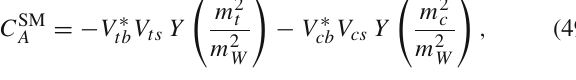
of the flavon to fermions. In the minimal model, y tc is